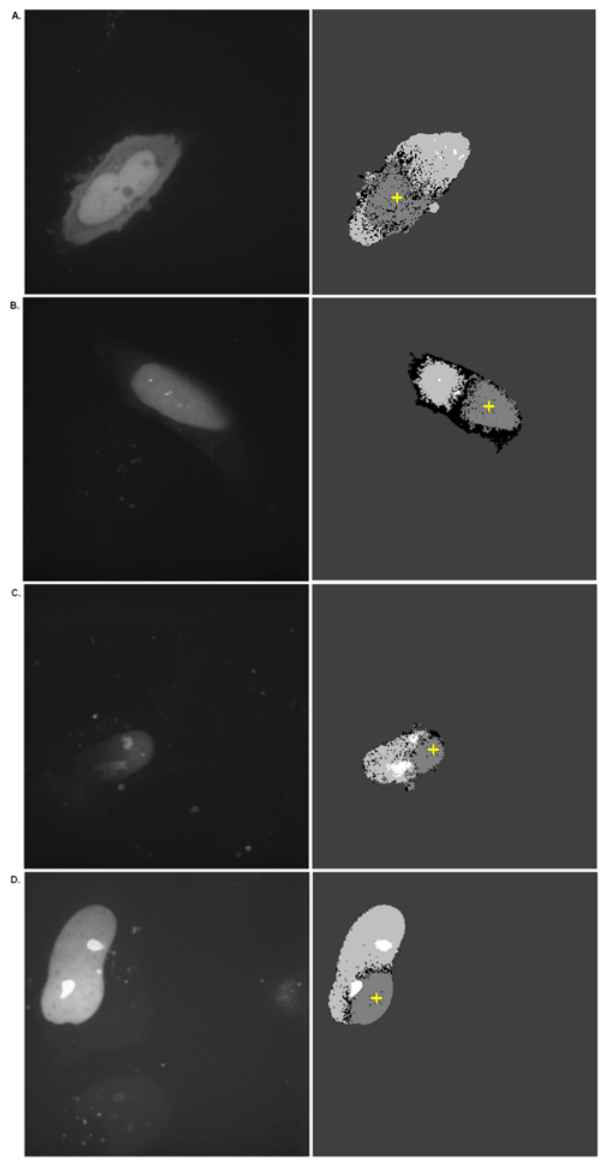
Fig 4. The Migration Map. (A) Dendra2; (B) Dendra2UBC9; (C) & (D) Dendra2-Fibrillarin. The sub-cellular migration of a selection of Dendra2 fusion proteins from the PC region is described in their mean (left) and corresponding classification images (right). The key is as follows: White: accumulation; Light grey: diffusion towards; Dark grey: injection; Darkest grey: background; Black: unclassified. The initial PC region is highlighted with a